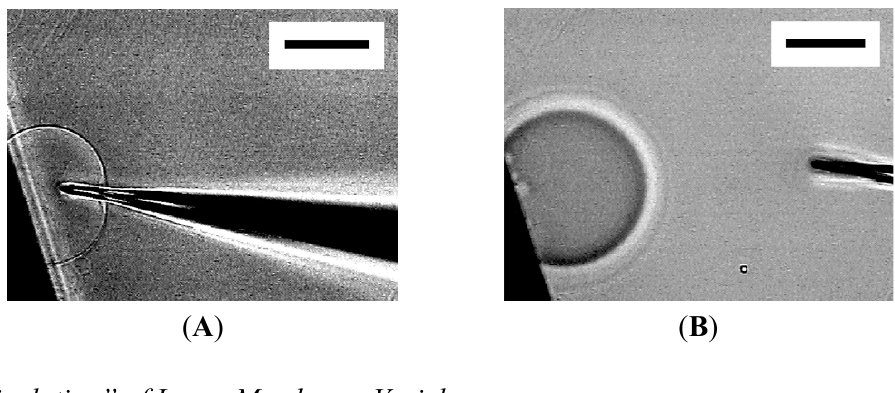
Figure 2. Microinjection into semi-spherical membrane. Images are a semi-sphere with a microneedle inserted ( A ), and after injection of Ficoll solution ( B ). Due to the difference in refractive index, the presence of Ficoll makes the object appear dark. The electrode appears as the black shadow at the lower left of the frame. Bar = 50 μ